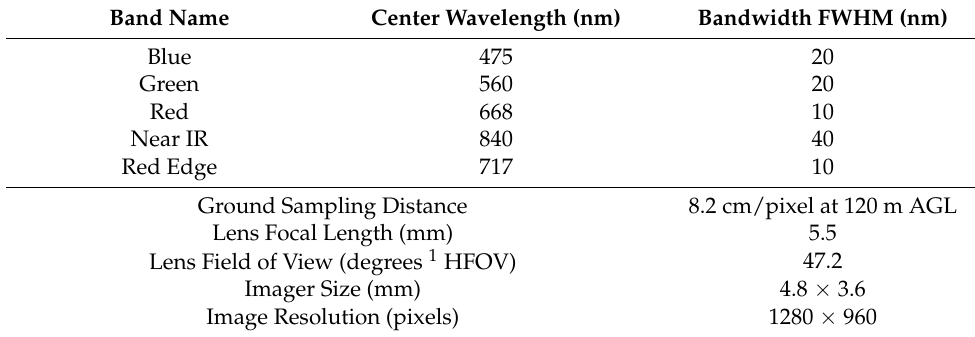
Table 2. MicaSense RedEdge multispectral camera